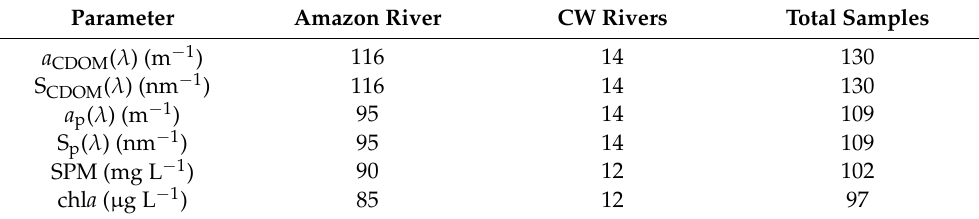
Table 1. Total number of in situ data gathered during the years of 2014–2017 in the Lower Amazon region. Parameter Amazon River CW